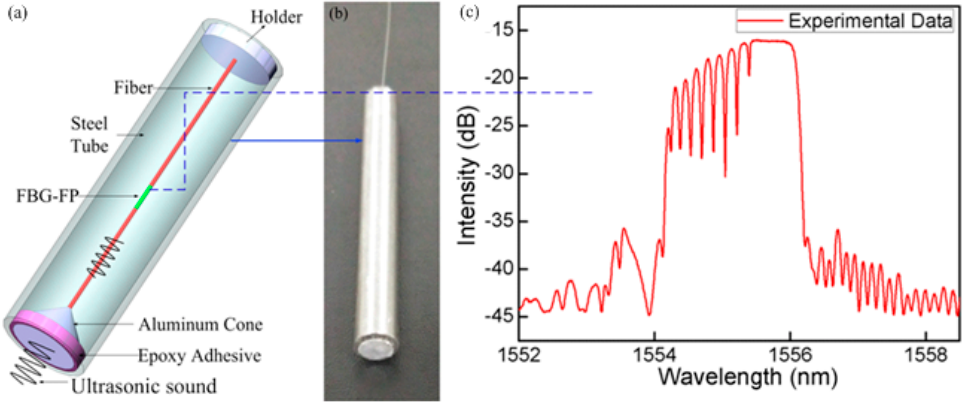
Figure 15. ( a ) Scheme diagram of directional FBG-FP sensor structure; ( b ) Photo image of the sensing probe; ( c ) FBG-FP spectrum with several interference dips overlapping on the top of the FBG resonance spectrum.